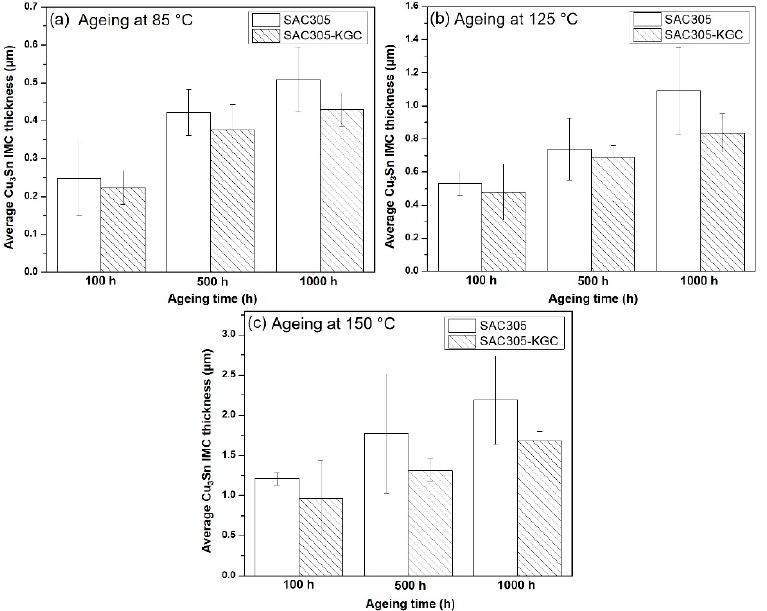
Figure 12. Average Cu 3 Sn IMC thickness subjected to isothermal ageing at temperature of ( a ) 85 °C, ( b ) 125 °C and ( c ) 150 °C. ( b ) 125 ◦ C and ( c ) 150 ◦